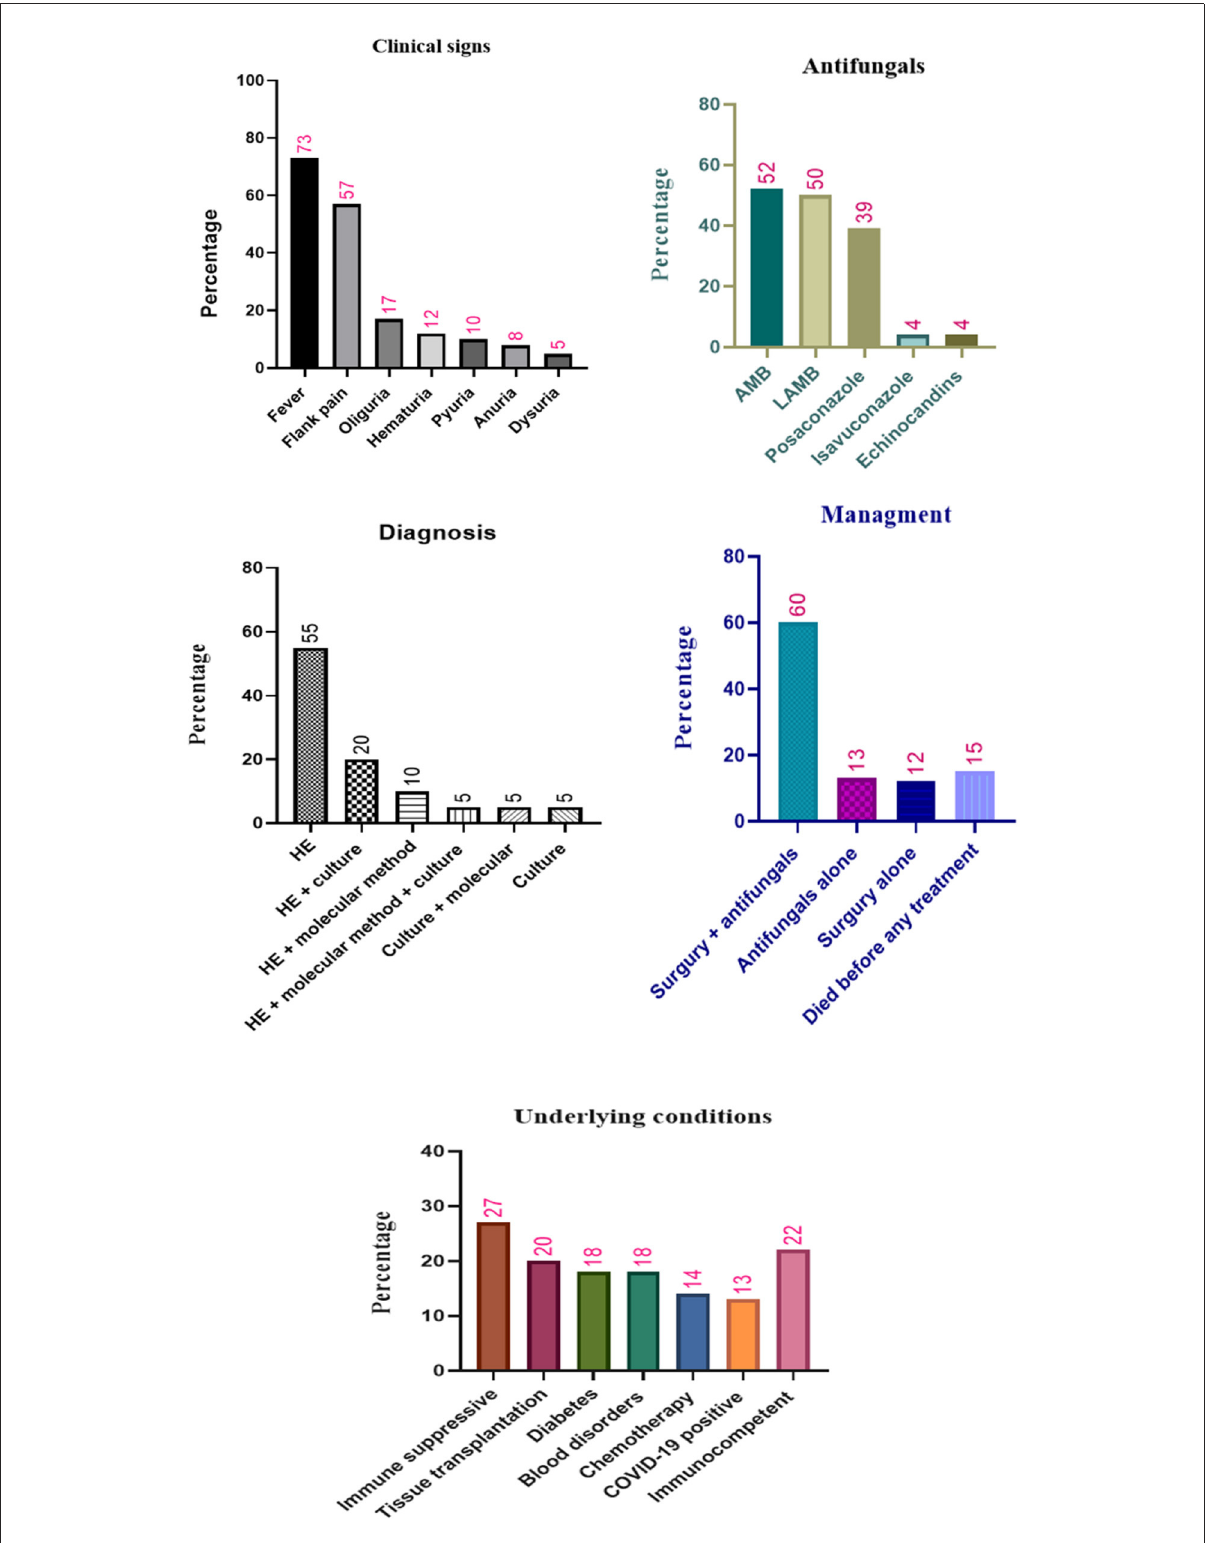
FIGURE2 Different characteristics and antifungals treatment of patients with renal mucormycosis. HE, histopathologic examination; AMB, amphotericin B; LAMB, liposomal amphotericin